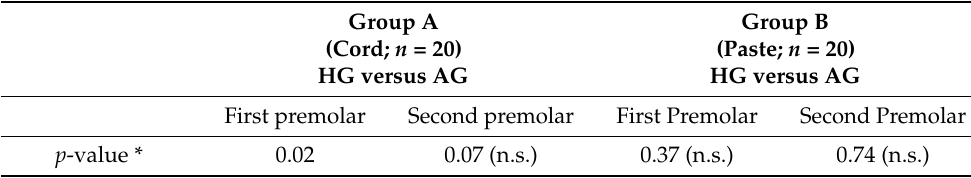
Table 3. Influence of the gingival condition (healthy gingiva (HG) versus artificial gingivitis (AG)) on the sulcus representation for the cord and the paste technique; *: t -Test for Dependent Samples; n.s.: not significant ( p ≥ 0.05 ).